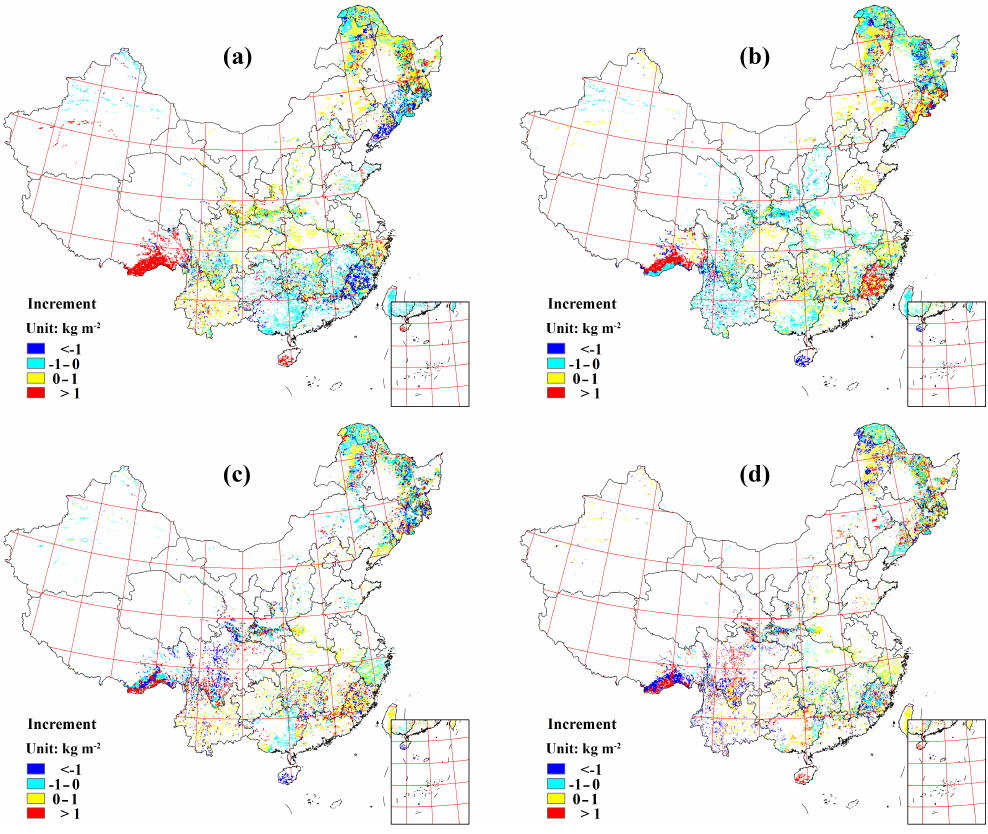
Figure 5. The increment maps of biomass carbon stocks from comparing two adjacent periods: (a) BCS in Period 2 minus BCS in Period 1,